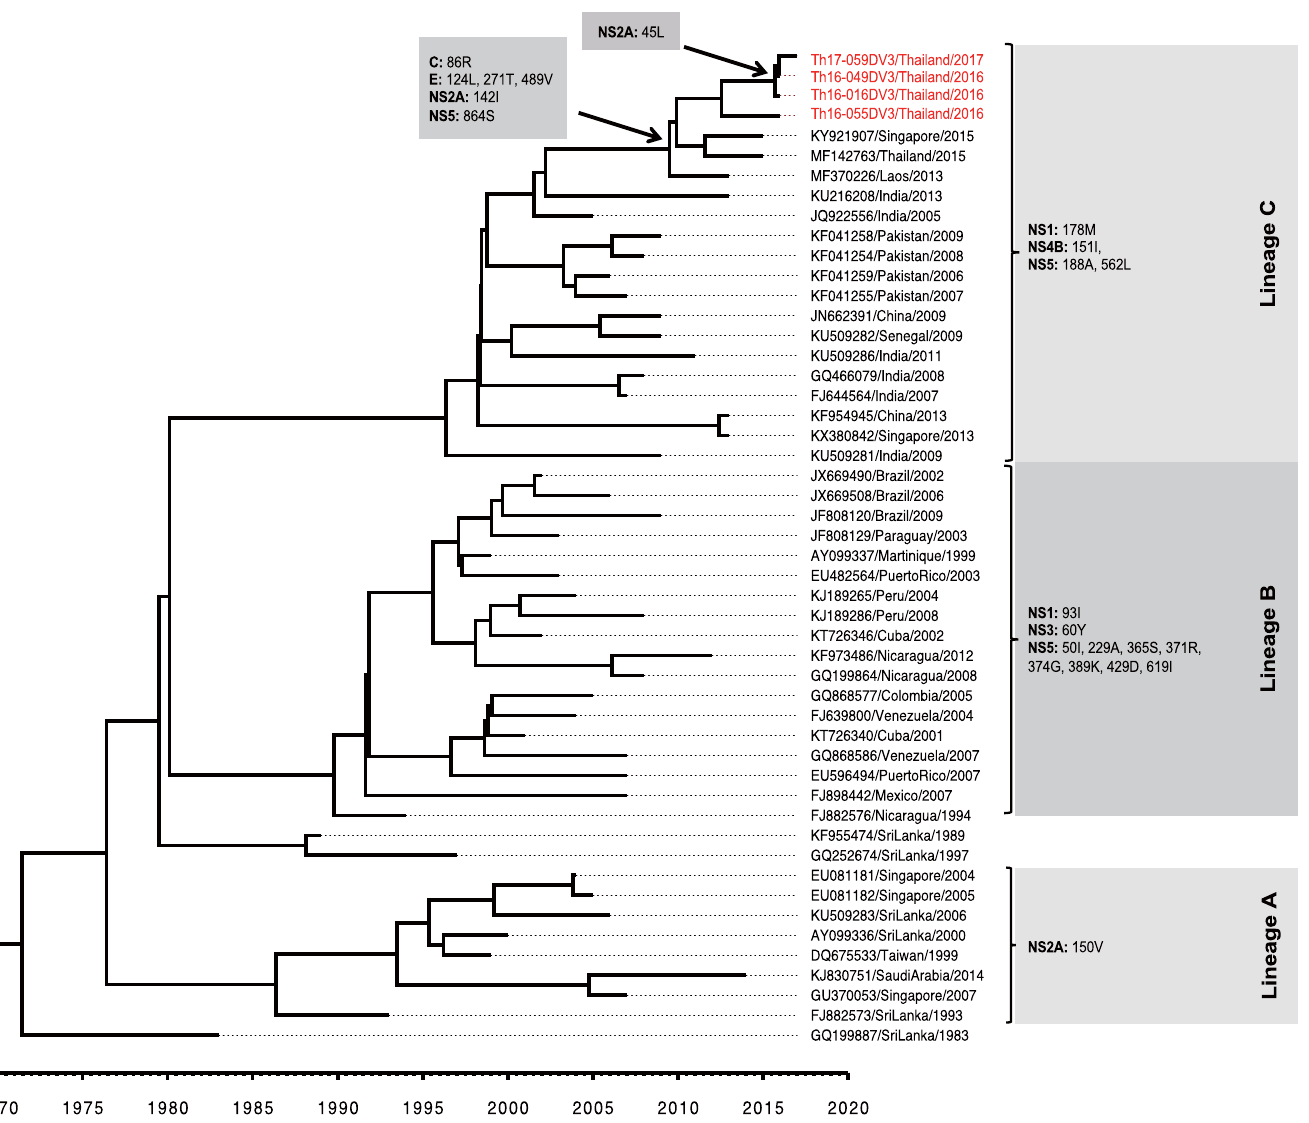
Fig 8. Amino acid variations among ORF proteins encoded by DENV-3 genotype III. The amino acid substitutions in the open reading frame among 3 lineages of DENV-3 genotype III (in the right panel) are shown corresponding to the lineages. The occurrences of the indicated amino acid variations are shown with arrows. Sequences obtained in this study are labeled in